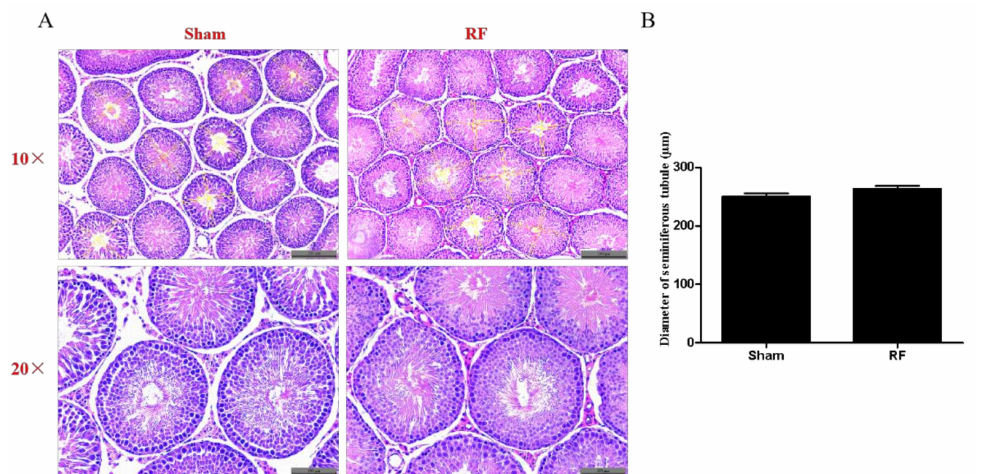
Figure 4. The effect of one-month 220 MHz pulsed modulated RF exposure on testis morphology of SD rats. ( A ) Hematoxylin–eosin (HE) staining, scale bar = 200 µ m (upper panel) and 100 µ m (lower panel); eight animals for each group. ( B ) Measurement of diameters of seminiferous tubules; 50 seminiferous tubules for each animal and eight animals for each group. The values were expressed as means ± SEM and were analyzed by student t -test. Mean differences were no significant ( p > 0.05).